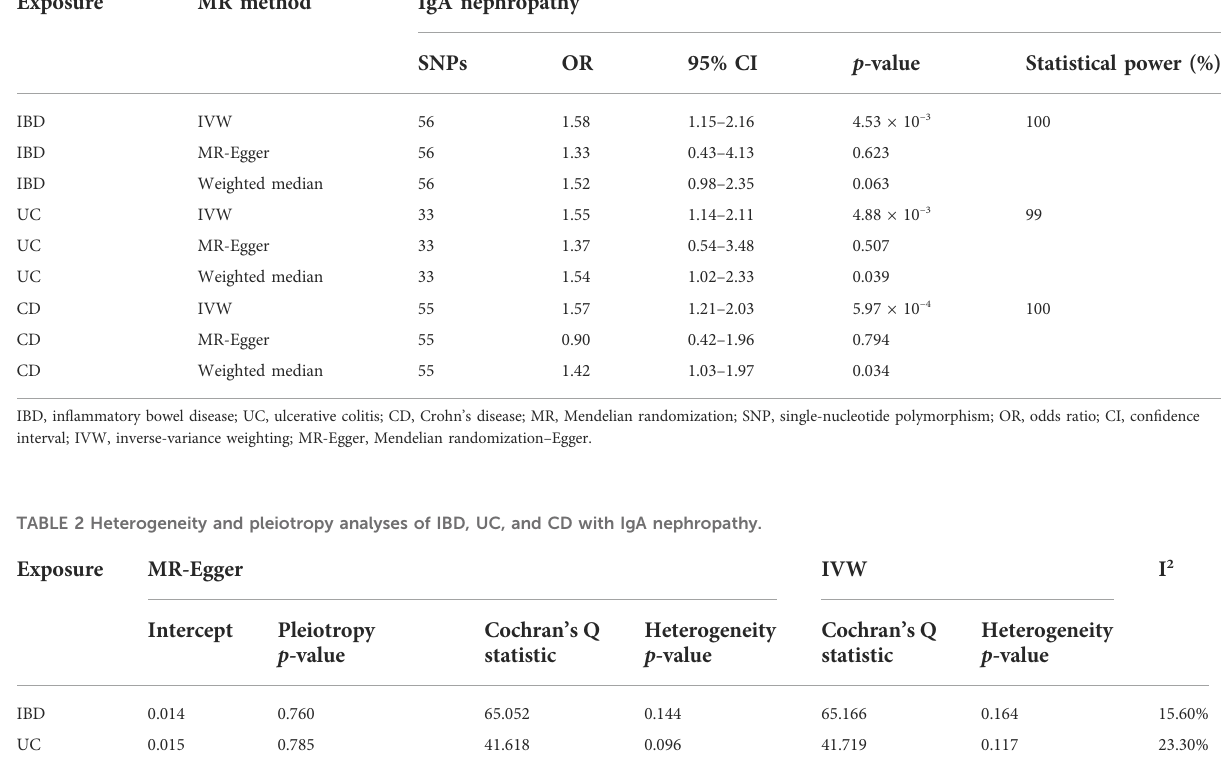
(Table 2). The “ leave-one-out ” sensitivity analysis evaluated the in fl uence of outlying or pleiotropic SNPs by leaving out each SNP in turn. The results revealed that the causal link between IBD and IgAN was not signi fi cantly affected by any one SNP (Supplementary Figure S4).